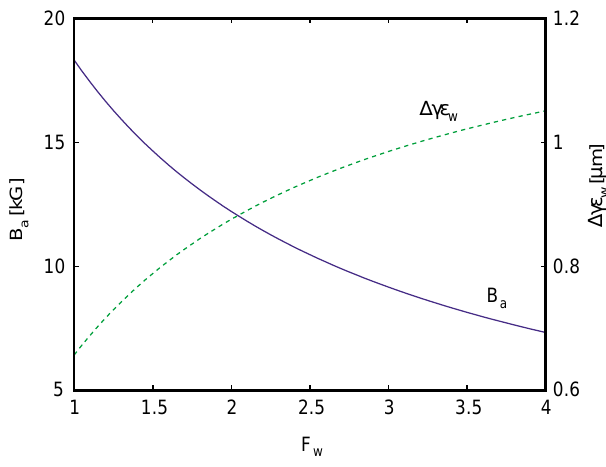
FIG. 12. (Color) Arc dipole field B a and wiggler’s emittance contribution Dg´ w plotted against F w